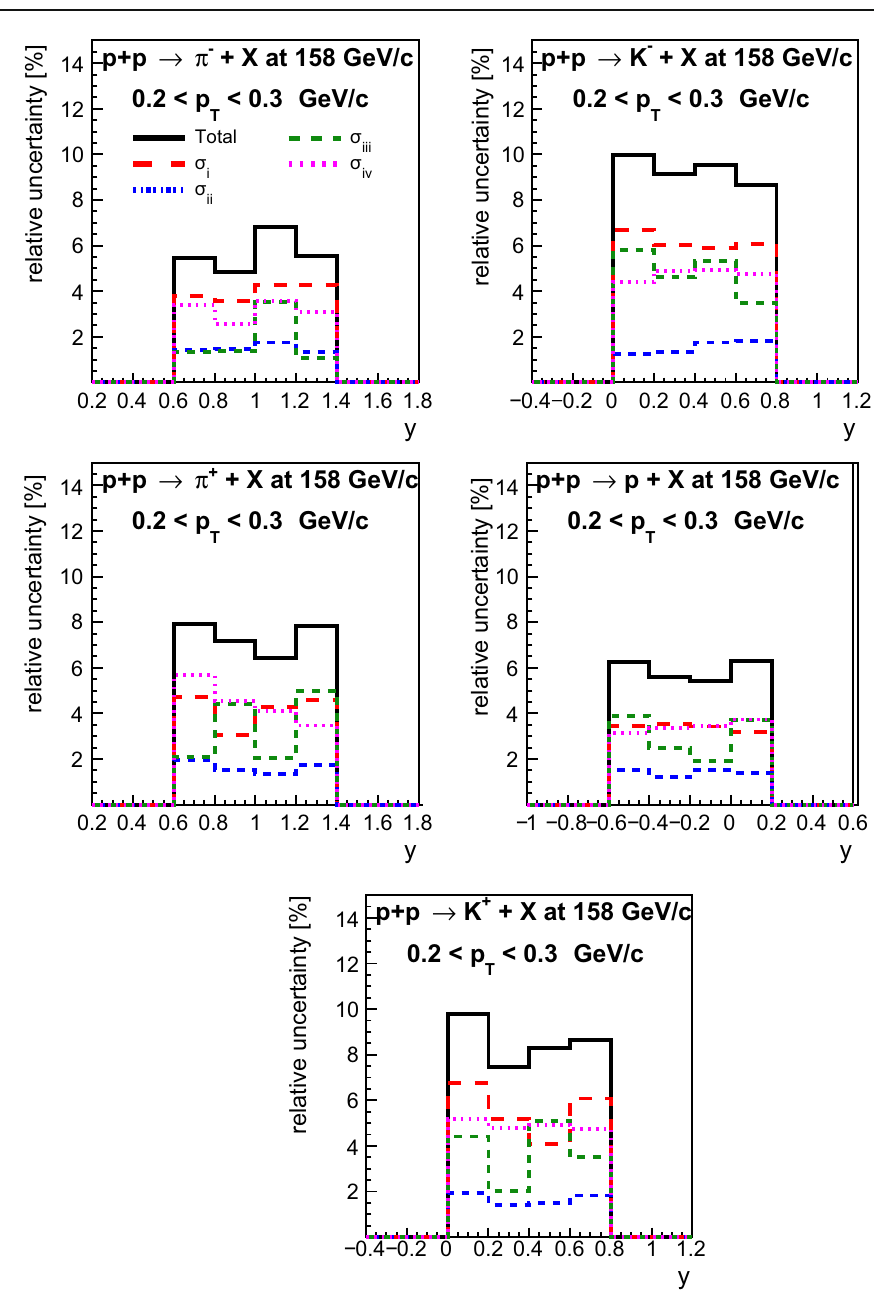
Fig. 19 Components of systematic uncertainty of particle spectra obtained from the tof -d E / d x method in inelastic p + p interaction at 158 GeV / c as function of rapidity for the transverse momentum interval between 0.2–0.3 GeV / c . σ i refers to removal of events with off-time beam tracks, σ ii to possible bias of the S4 trigger, σ iii to event vertex and track selection procedure and σ iv to the identification technique. Black lines (Total) show the total systematic uncertainty calculated as the square root of the sum of squares of the